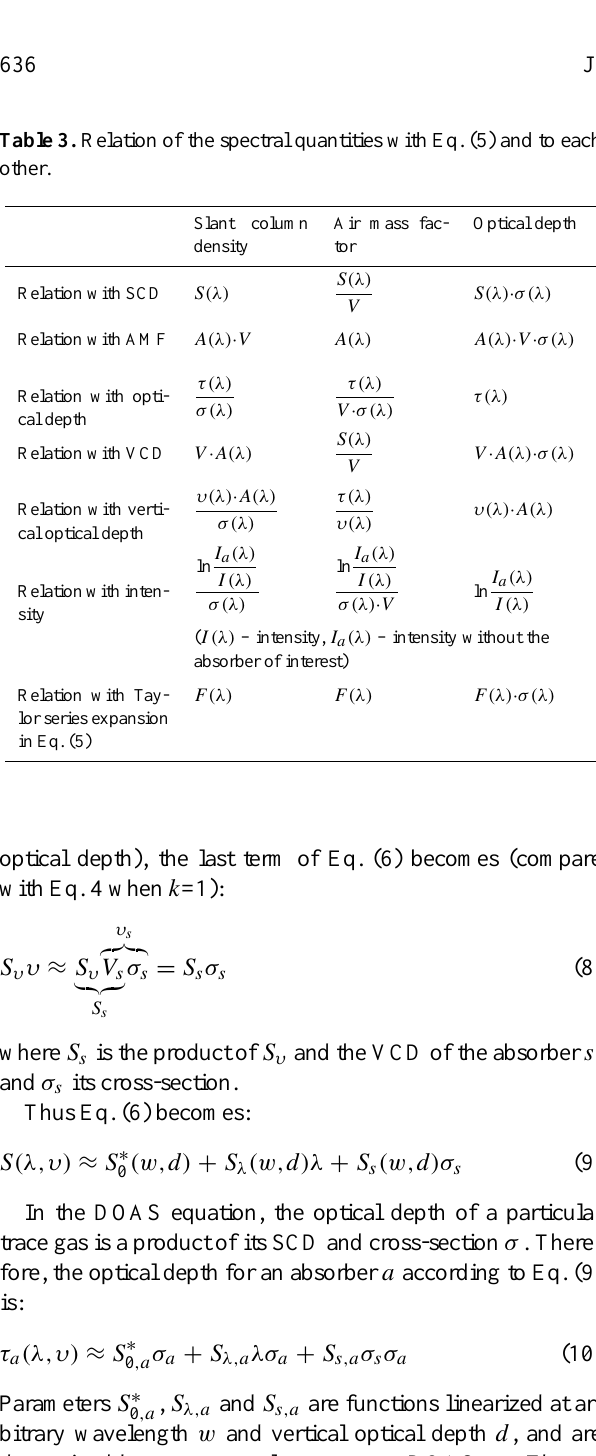
Table 3. Relation of the spectral quantities with Eq. (5) and to each other.